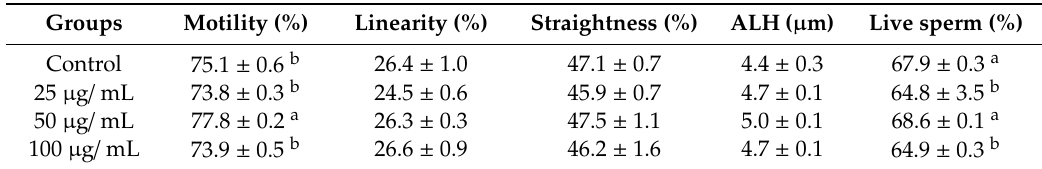
Table 2. Determination of optimal concentration of exosomal proteins for cryopreservation of dog sperm after incubation 4 ◦ C for 8–10